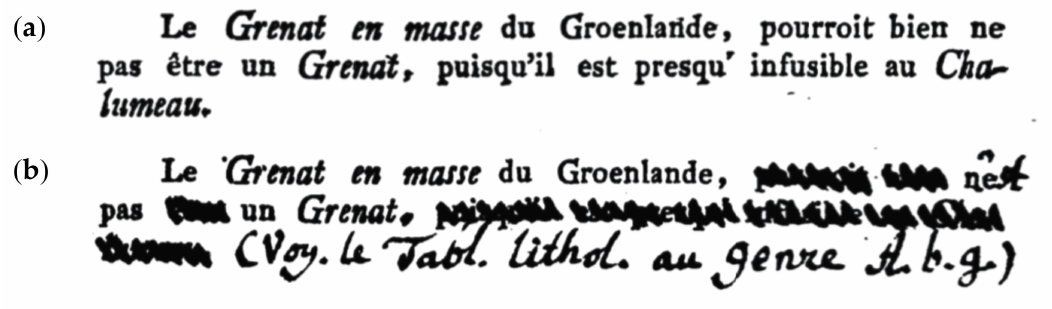
Figure 2. A snippet from Gallitzin’s entry on the garnet group in Recueil ([13], p. 116): ( a ) Gallitzin’s original text; ( b ) The edit made by one of the book’s subsequent owners, claiming that greenlandite is not a